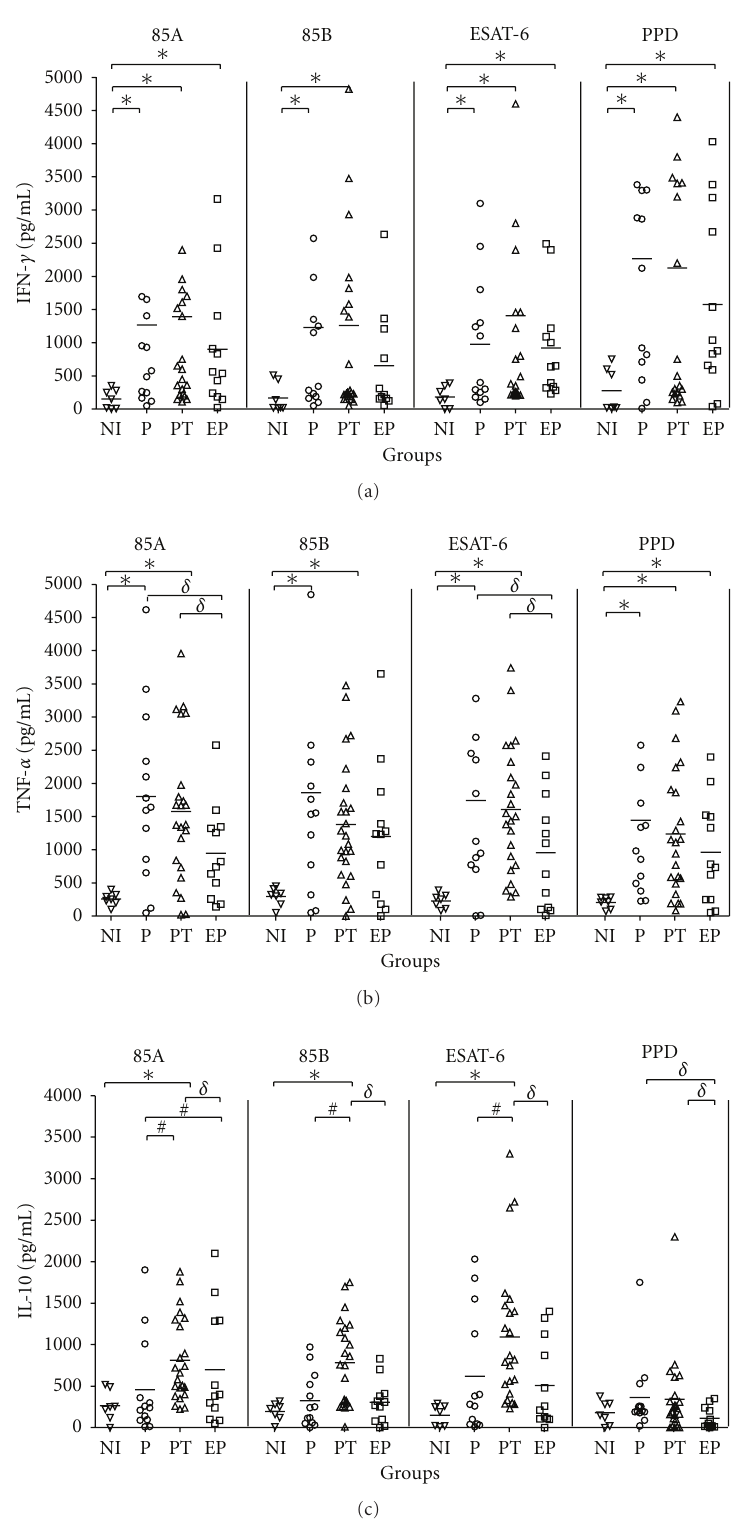
Figure 4: Individual IFN- γ (a), TNF- α (b), and IL-10 (c) production in response to recombinant Ag85A, Ag85B, and ESAT-6. Freshly isolated PBMC from non-infected individuals (NI), pulmonary TB patients (P), pulmonary TB patients in treatment (PT), and extra-pulmonary TB (EP) were cultured in the presence of Ag85A (25 μ g/ml), Ag85B (25 μ g/ml), PPD (25 μ g/ml), or ESAT6 (50 μ g/ml). Supernatants were harvested after five days and the cytokines measured by ELISA. Horizontal bars represent mean values. Di ff erences between responses from TB patient groups and control groups were analyzed with nonparametric Kruskall-Wallis test. ∗ Statistically significant di ff erences in relation to NI group, ( δ ) in relation to EP group, and (#) in relation to P group ( P < .